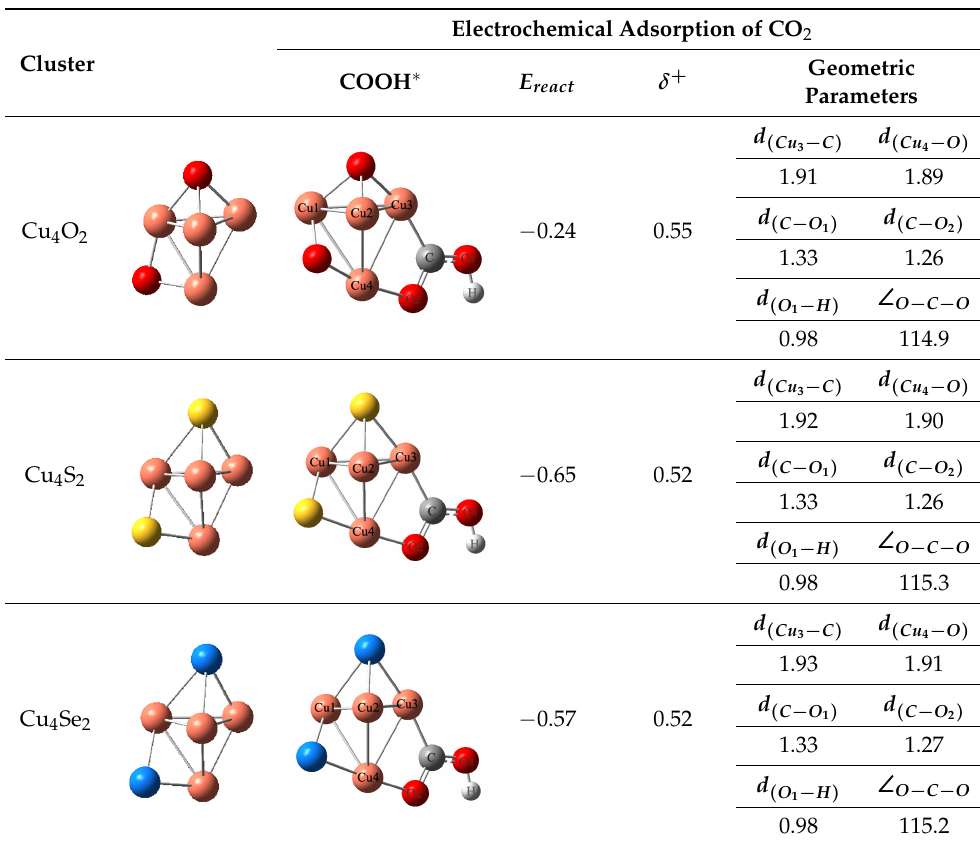
Table 1. The GM of the Cu 4 X 2 cluster and structural details of electrochemical CO 2 adsorption on the Cu 4 X 2